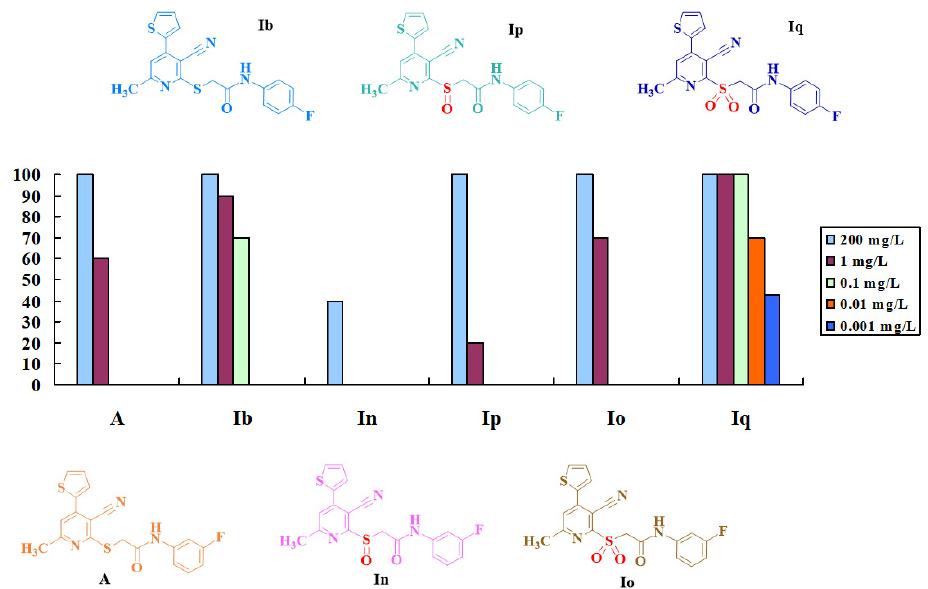
Figure 4. The larvicidal activity contrast diagram of compounds A , Ib , In , Ip , Io and Iq against diamondback moth ( Plutella xylostella L.) at different test concentrations.